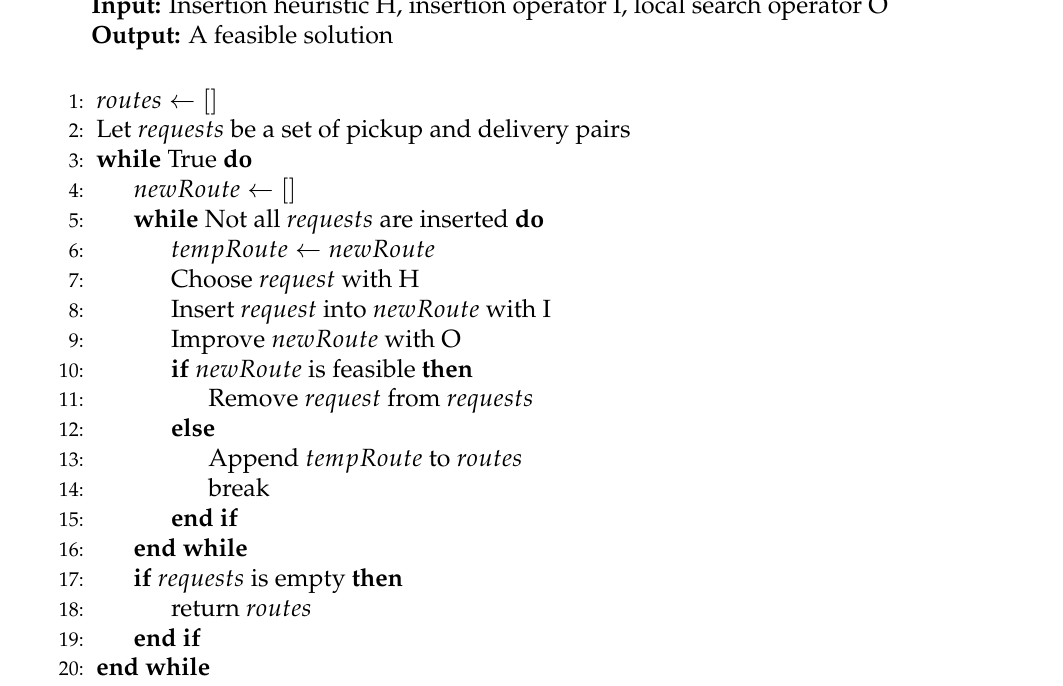
Algorithm 3 Sequential